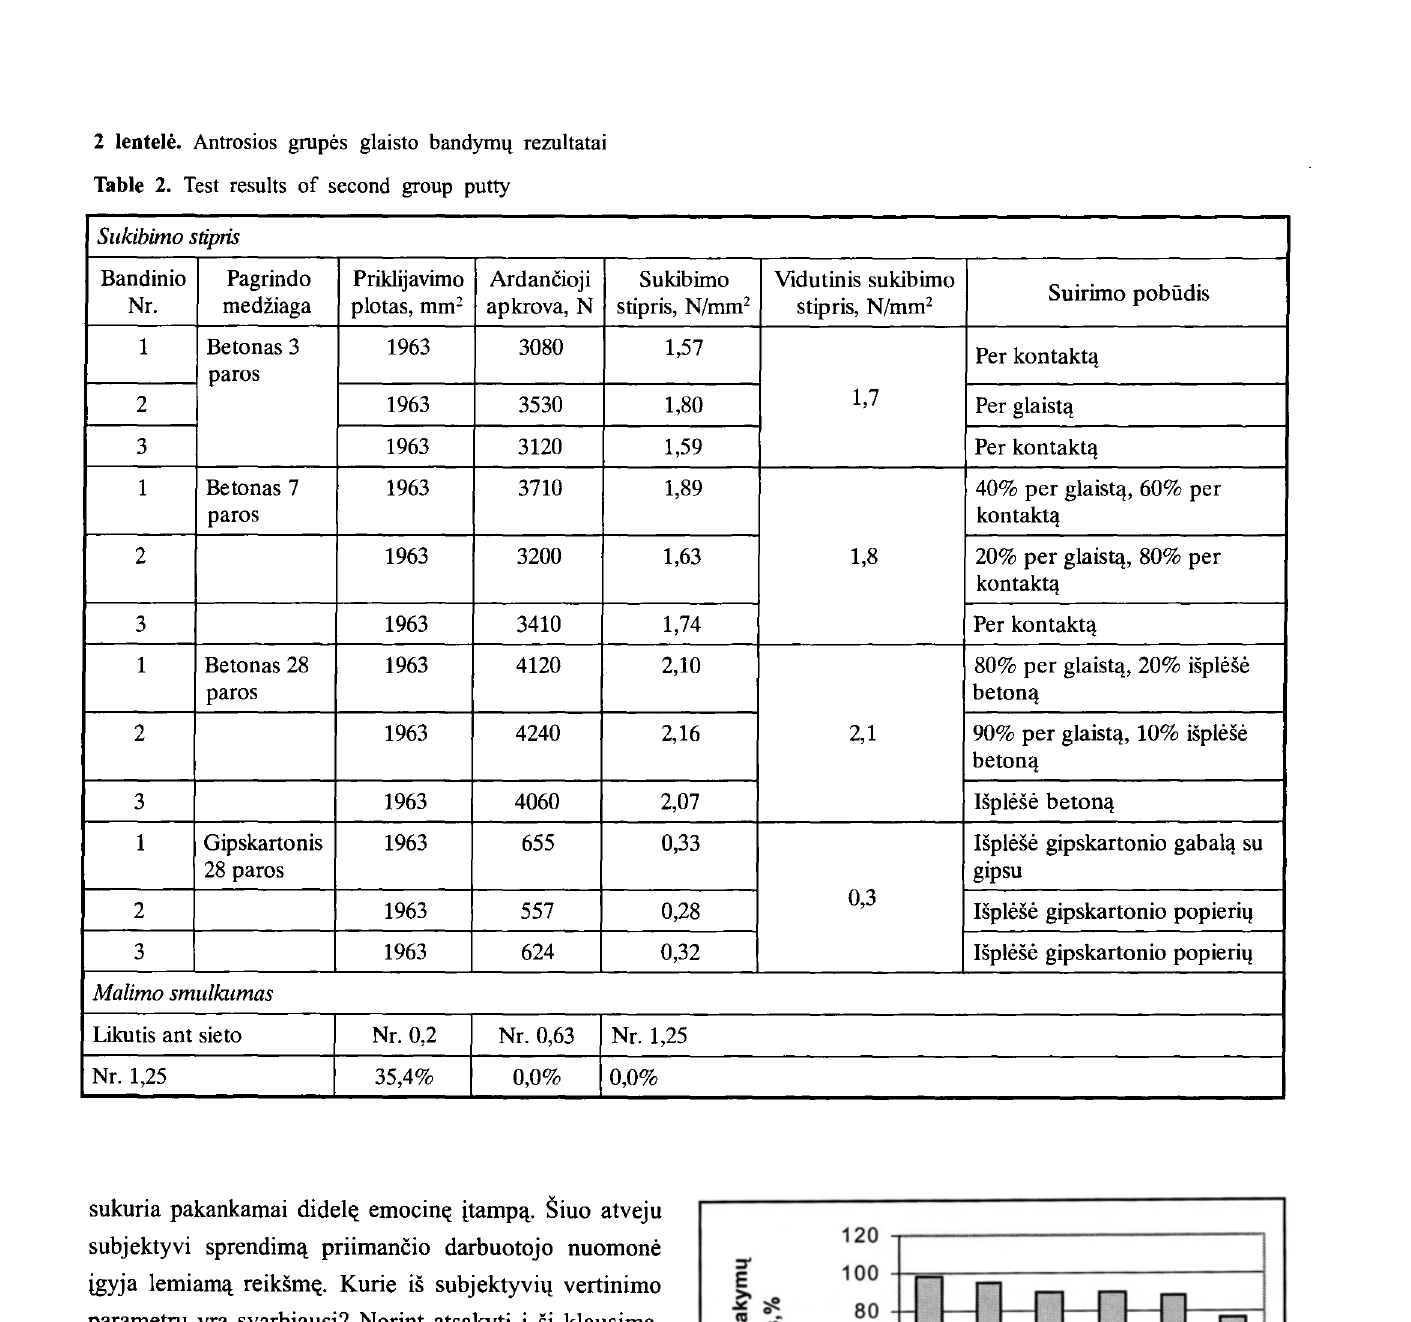
2 lentele. Antrosios grupes glaisto bandymq rezultatai Table 2. Test results of second group putty